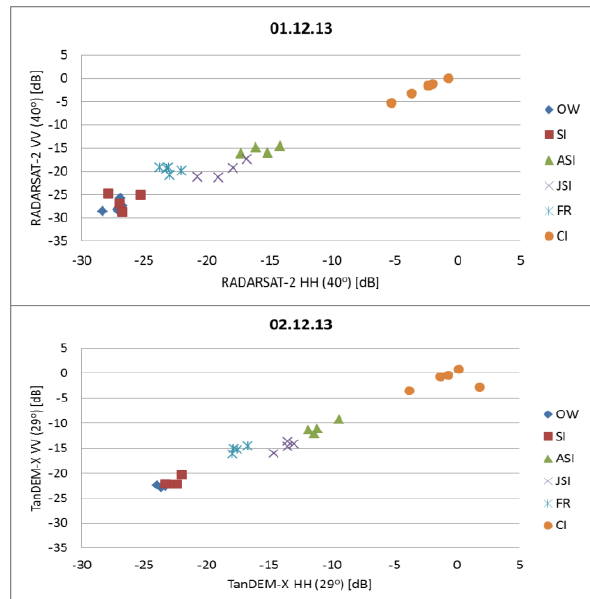
Figure 4. Backscattering values (in dB) in HH and VV polarisations for RADARSAT-2 (upper image) and TerraSAR- X (lower image) acquired on 1 st and 2 nd December. Abbreviations: OW for open water, SI for skim ice, ASI for agglomerated skim ice, JSI for juxtaposed skim ice, FR for frazil run and CI for consolidated ice (frazil or skim ice)